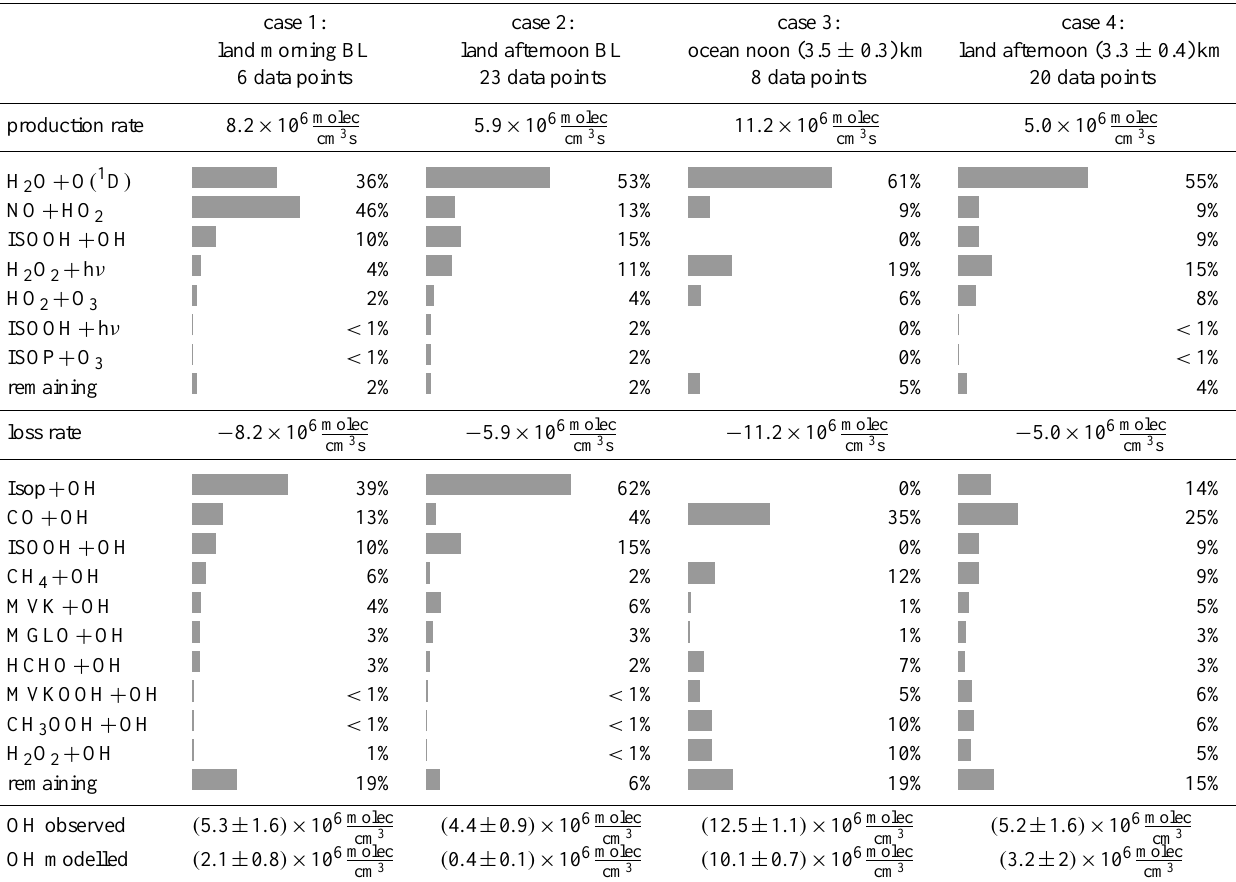
Table 7. OH budget based on a model analysis of measurement